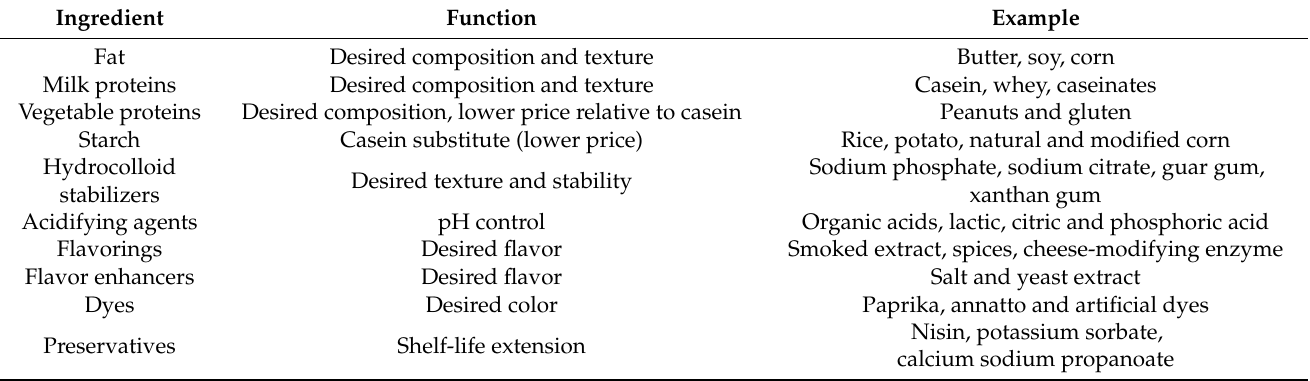
Table 6. Ingredients used in cheese analogue production (adapted from